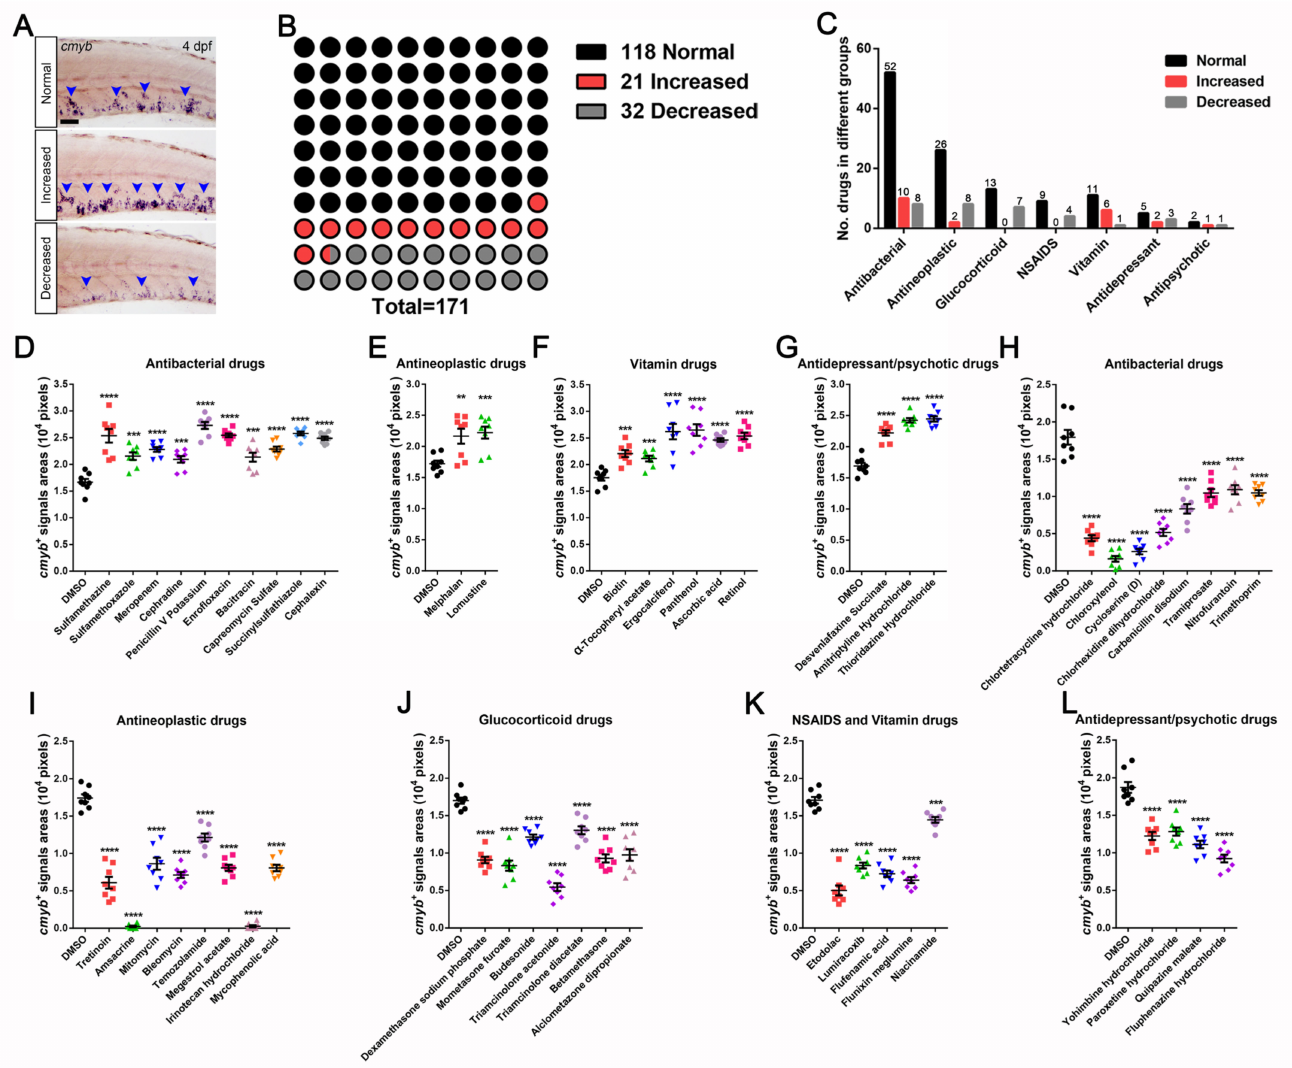
Figure 2. Preliminary FDA-approved drug screening results for cmyb + HSPCs in zebrafish embryos. ( A ) Examples of screening and phenotyping between cmyb in situ hybridization phenotypes in comparison with the normal control zebrafish. ( B ) Statistical summary of drugs available, including normal signals (118 compounds), increased signals (21 compounds), and decreased signals (32 compounds). ( C ) Statistical diagram of drugs represented by each category. ( D – G ) The drug treatments augment cmyb + signals. ( D ) Antibacterial drugs (Pixels; DMSO, 16,680 ± 608; Sulfamethazine, 25,360 ± 1281; Sulfamethoxazole, 21,540 ± 699; Meropenem, 22,790 ± 443; Cephradine, 20,940 ± 616; Penicillin V Potassium, 27,290 ± 647; Enrofloxacin, 25,450 ± 355; Bacitracin, 21,350 ± 841; Capreomycin Sulfate, 22,860 ± 454; Succinylsulfathiazole, 25,800 ± 341; Cephalexin, 24,890 ± 348). ( E ) Antineoplastic drugs (Pixels; DMSO, 17,230 ± 509; Melphalan, 21,650 ± 1205; Lomustine, 22,230 ± 963). ( F ) Vitamin drugs (Pixels, DMSO, 17,530 ± 552; Biotin, 22,050 ± 651; α -Tochopheryl acetate, 21,130 ± 528; Ergocalciferol, 26,190 ± 1457; Panthenol, 26,490 ± 1084; Ascorbic acid, 24,610 ± 345; Retinol, 25,380 ± 622). ( G ) Antidepressant/psychotic drugs (Pixels; DMSO, 16,910 ± 483; Desvenlafaxine Succinate, 22,210 ± 437; Amitriptyline signals. ( H ) Antibacterial drugs (Pixels; DMSO, 17,940 ± 985; Chlortetracycline hydrochloride, 4400 ± 3402; Chloroxylenol, 1625 ± 380; Cycloserine ( D ), 2600 ± 369; Chlorhexidine dihydrochloride, 5163 ± 479; Carbenicillin disodium, 8325 ± 638; Tramiprosate, 10,450 ± 543; Nitrofurantoin, 10,900 ± 614; Trimethoprim, 10,480 ± 376). ( I ) Antineoplastic drugs (Pixels; DMSO, 17,410 ± 505; Tretinoin, 6088 ± 783; Amsacrine, 238 ± 107; Mitomycin, 8625 ± 802; Bleomycin, 7125 ± 394; Temozolamide, 12,130 ± 531; Megestrol acetate, 8075 ± 420; Irinotecan hydrochloride, 263 ± 145; Mycophenolic